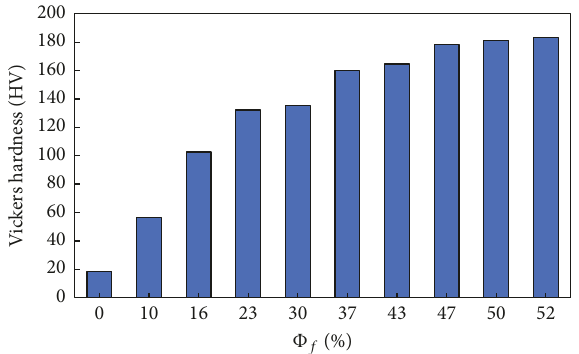
Figure 10: Hardness as a function of vol.% of Cu in UPR matrix.